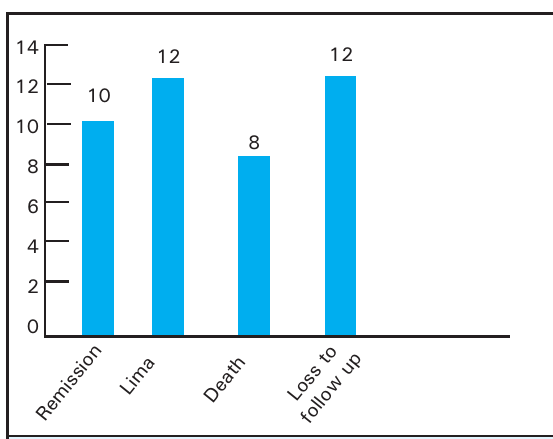
Figure 5. Showing prognosis of retinoblastoma